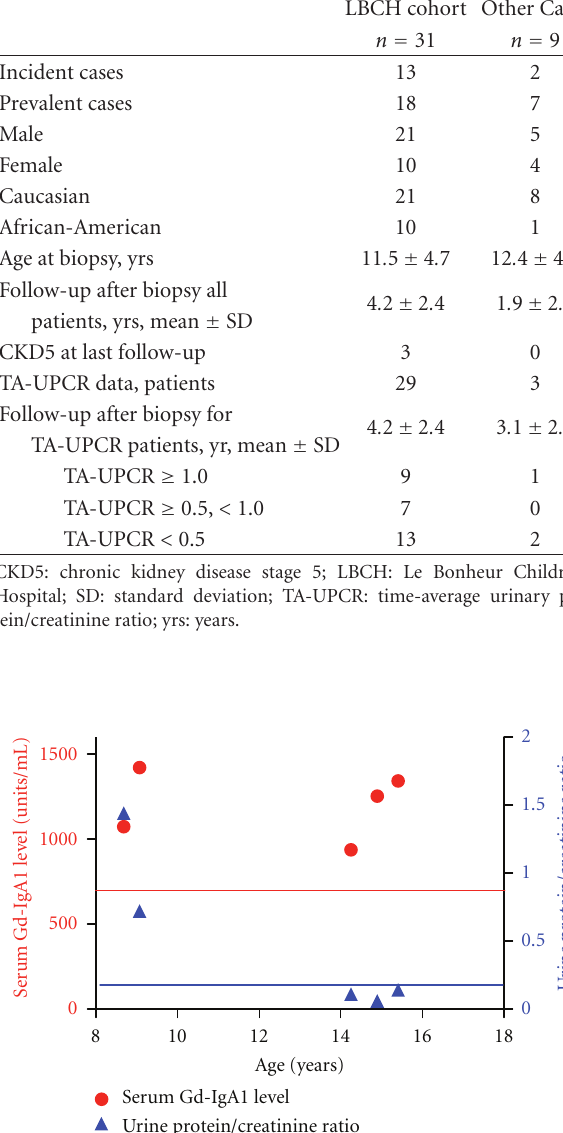
Figure 4: Serum Gd-IgA1 levels (red circles) and concomitant urinary protein/creatinine ratios are plotted for the patient having the most serum Gd-IgA1 determinations. The red line represents the 95th percentile for serum Gd-IgA level in healthy pediatric controls, and the blue line represents the upper limit of normal for urinary protein/creatinine ratio of 0.2. This time course is of interest in that the initial value was at presentation with gross hematuria and the last three values were obtained during clinical remission (normal urinalysis and estimated